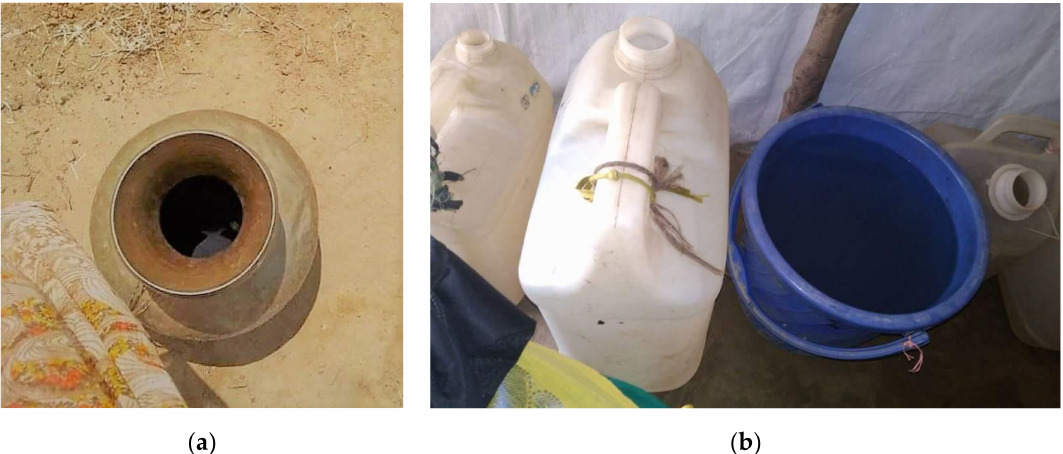
Figure 4. Water collection and storage container ( a ) Kolshi , ( b ) jerrycan, and